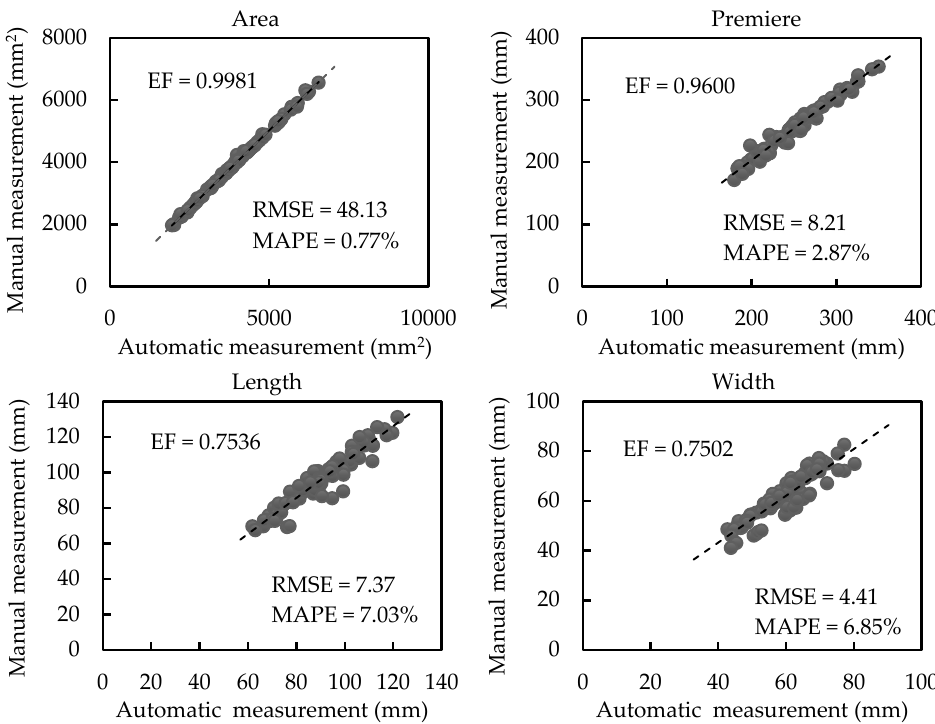
Figure 10. Regression analyses between automatic and manual measurements of scale-related traits of plants with heavy occlusion (plants in group 4).